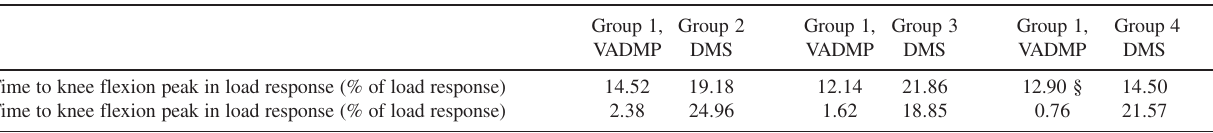
VADM - absolute value of the means difference; DMS - least significant difference; § Groups values approximation